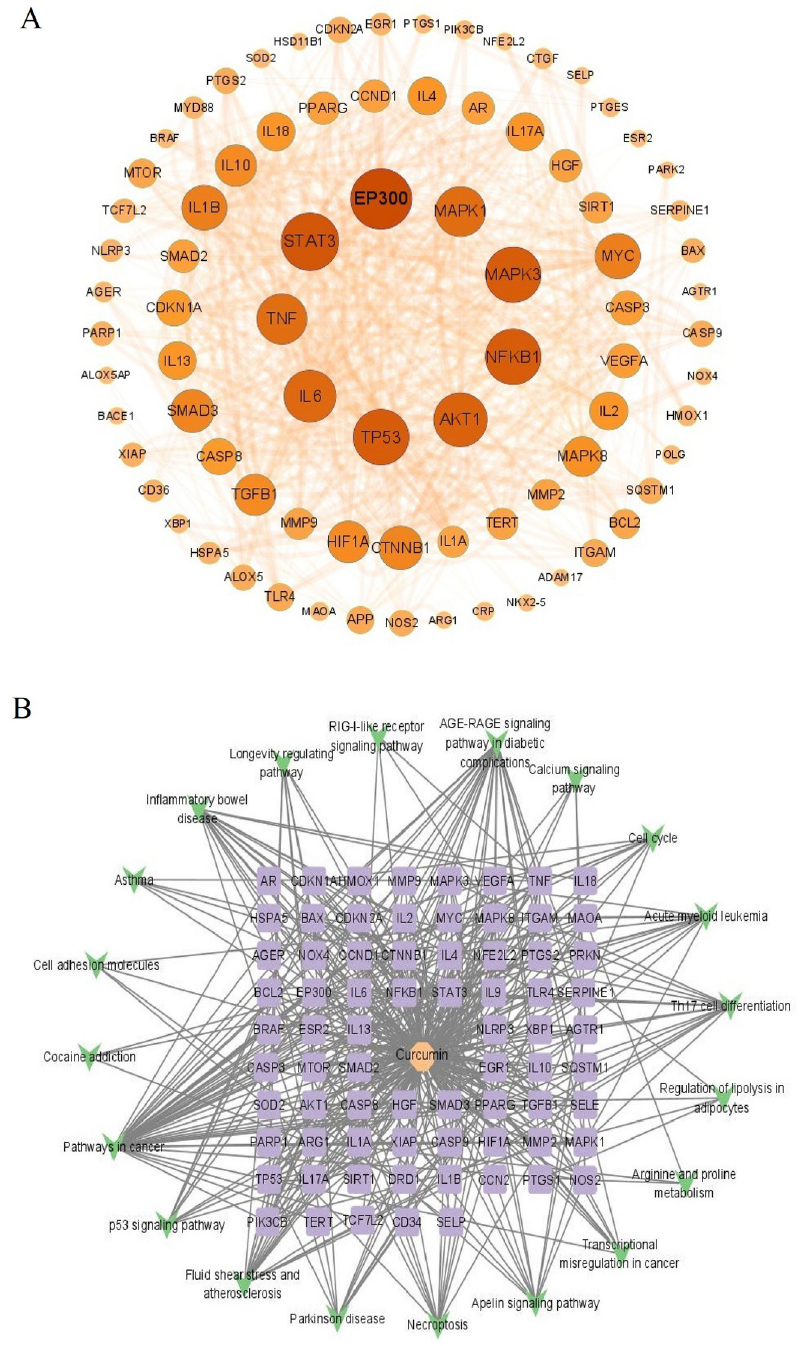
Fig 5. (A) PPI network diagram. (B) Curcumin–pathway–target network diagram. The green quadrilateral represents the KEGG pathway, the purple oval represents the target gene, and the pink hexagon represents curcumin.